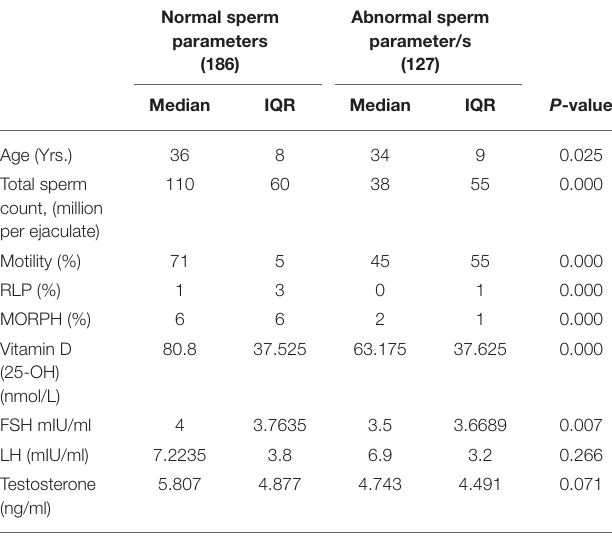
TABLE 1A | Comparison of study variables in groups characterized by normal and abnormal sperm parameters. Normal sperm Abnormal sperm parameters parameter/s (186)